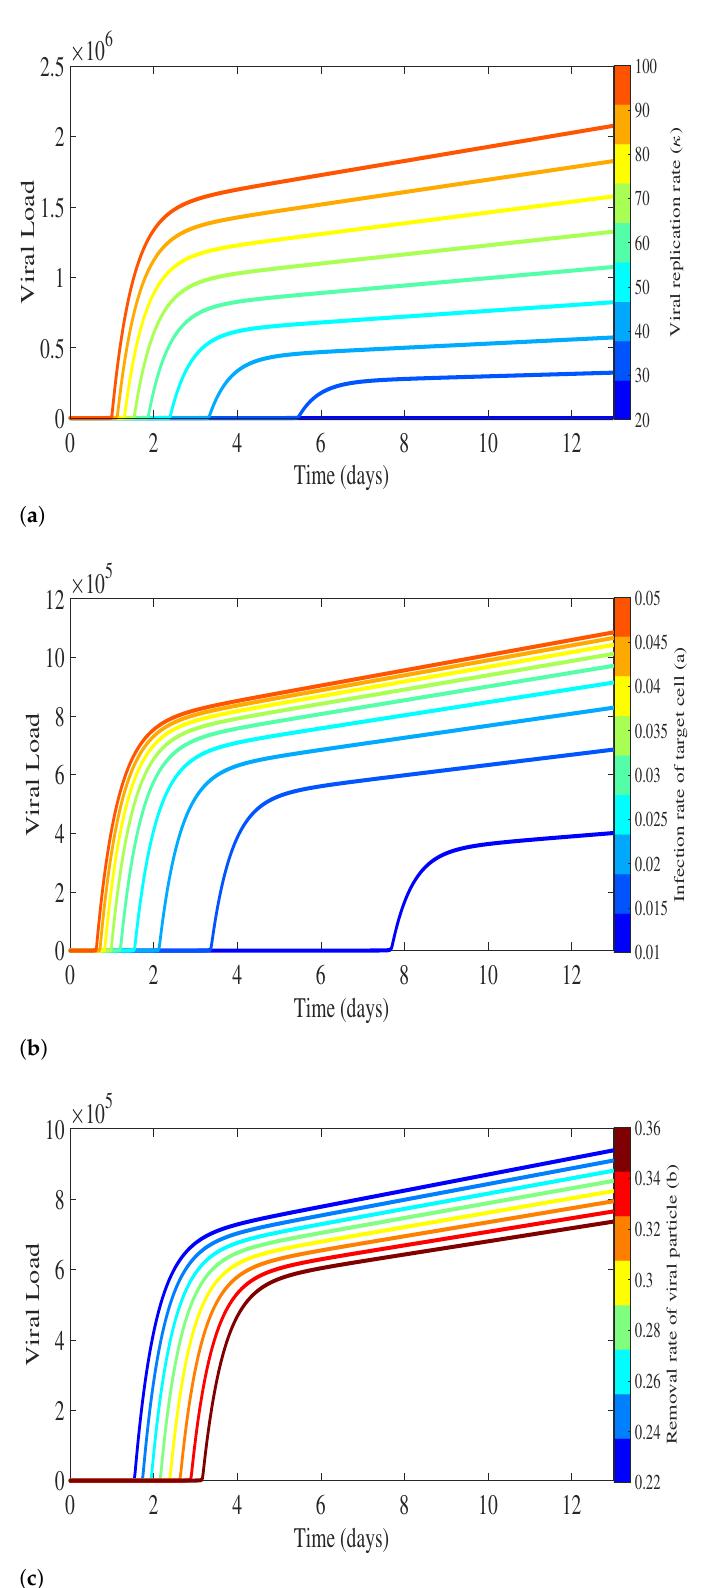
Figure 3. Sensitivity analysis for the parameters involved on free virus dynamics. ( a ) For fixed a = 0.02 and b = 15 a parameters, we vary the viral replication factor κ in the range [ 20,100 ] . ( b ) For fixed κ = 50 and b = 0.3, we vary the infection rate of susceptible cells parameter a in the range [ 0.01,0.05 ] . ( c ) The removal rate of viral particles b is varied in the range [11 a ,18 a ] with of fixed κ = 50 and a =